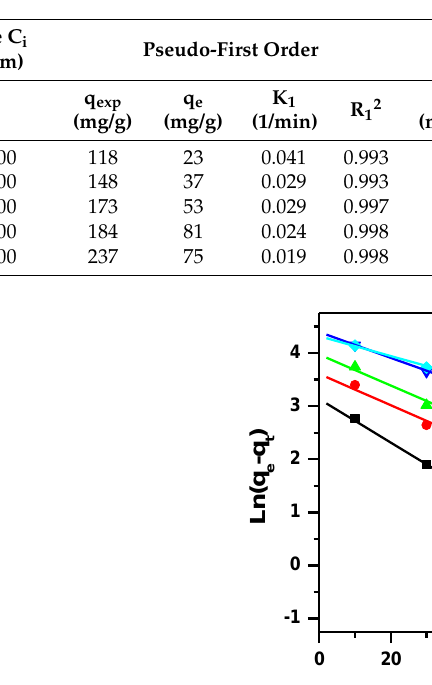
Table 2. Kinetic parameters for removal of MB using MNS-4.